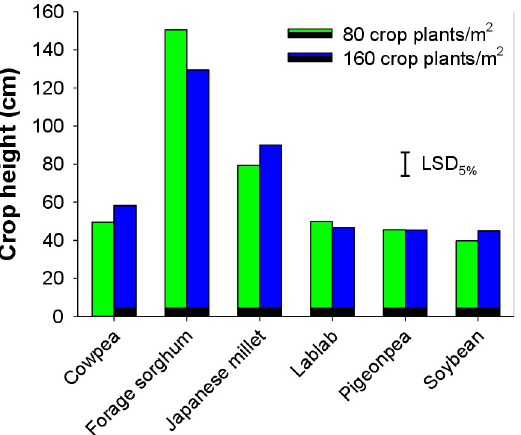
Fig 7. Plant height of various cover crops at planting densities of 80 and 160 plants m -2 .